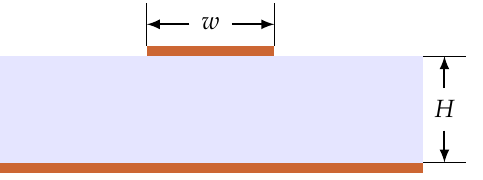
Figure 3. Microstrip transmission line structure cross-section.